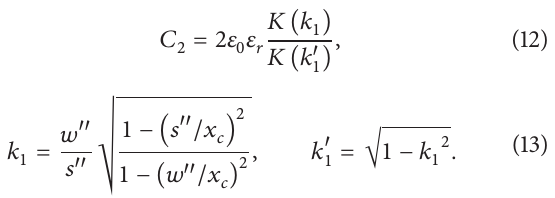
Figure 9: Characteristic impedances as a function of 𝑤/ℎ and 𝑠/ℎ (cal.: calculated, sim.: simulated). In case of (a), 𝑠 = 40 mil, 𝑔 = 10 mil, = 200 mil, 𝑤 = 200 mil, ℎ = 80 mil, and ℎ = 200 mil. In case of (b), 𝑤 = 70 mil, 𝑔 = 10 mil, ℎ = 8 mil, 𝑤 ℎ = 8 mil, 𝑤 1 2 1 2 = 200 mil, ℎ = 80 mil, and ℎ = 200 𝑤 2 1 2